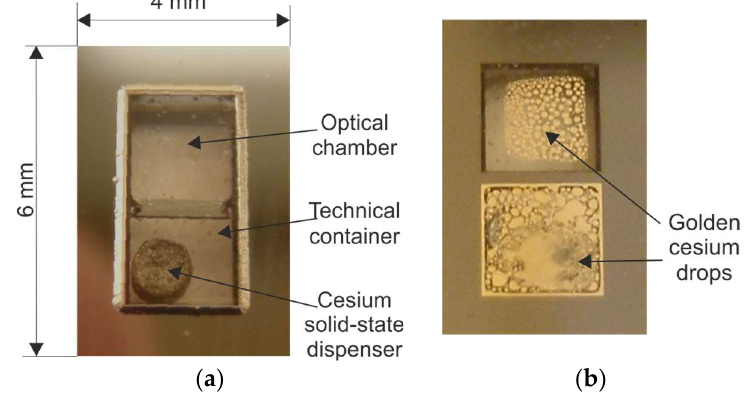
Figure 13. MEMS cell with solid-state dispenser: ( a ) before dispenser activation, ( b ) after the activation.